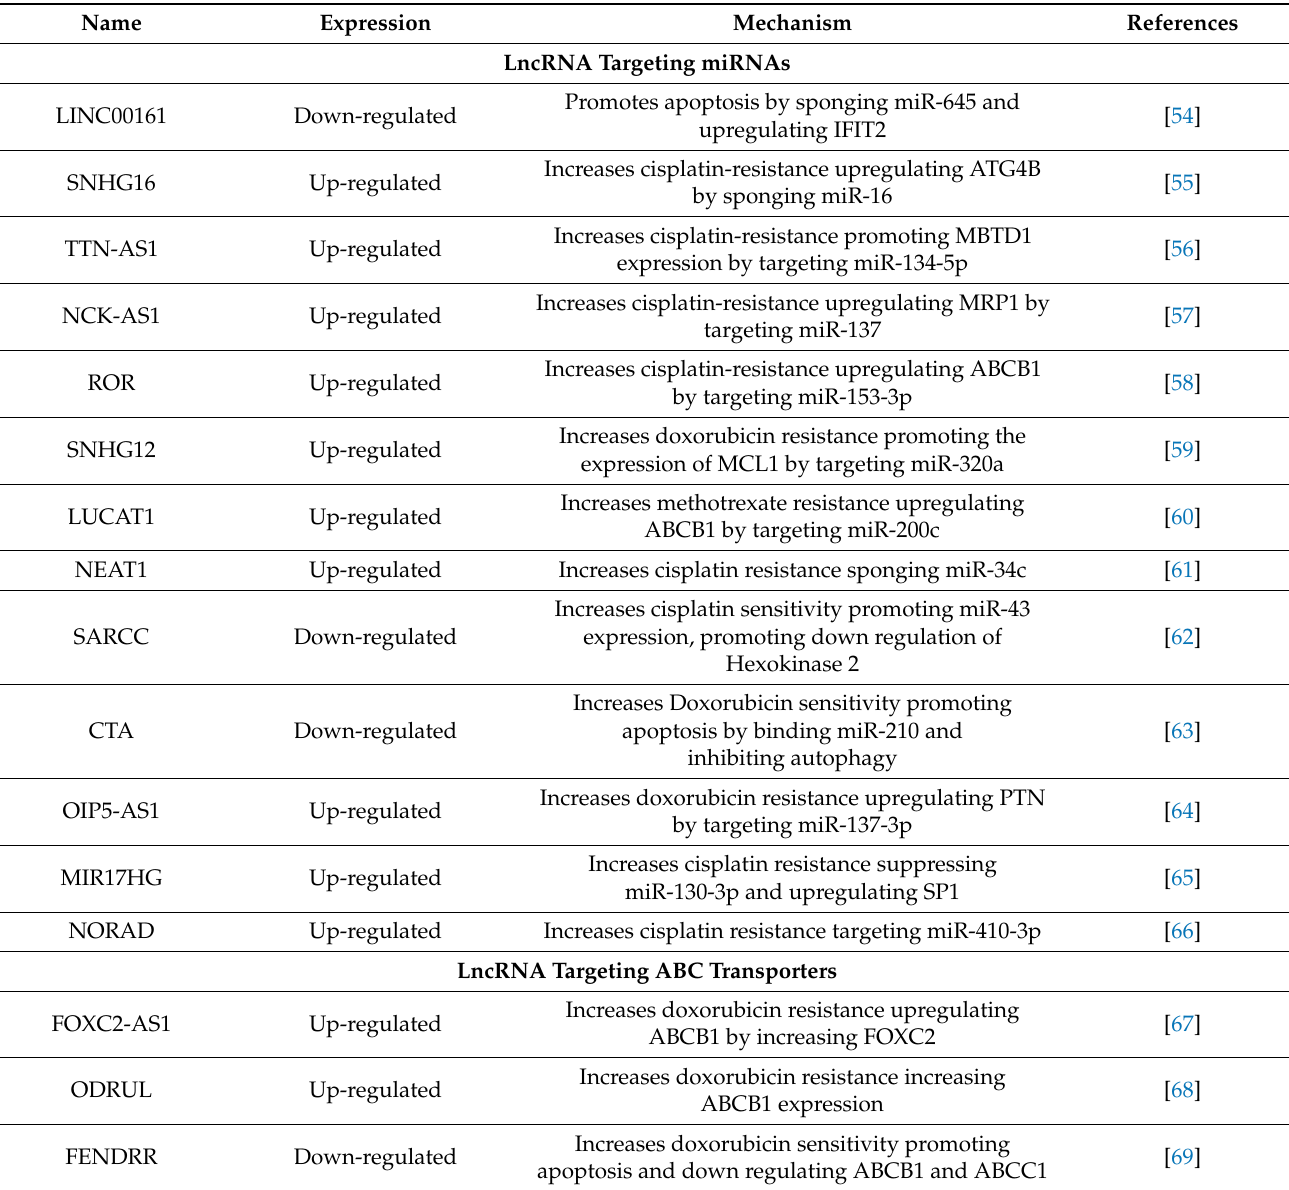
Table 1. List of non-coding RNAs indicated to be involved in osteosarcoma drug